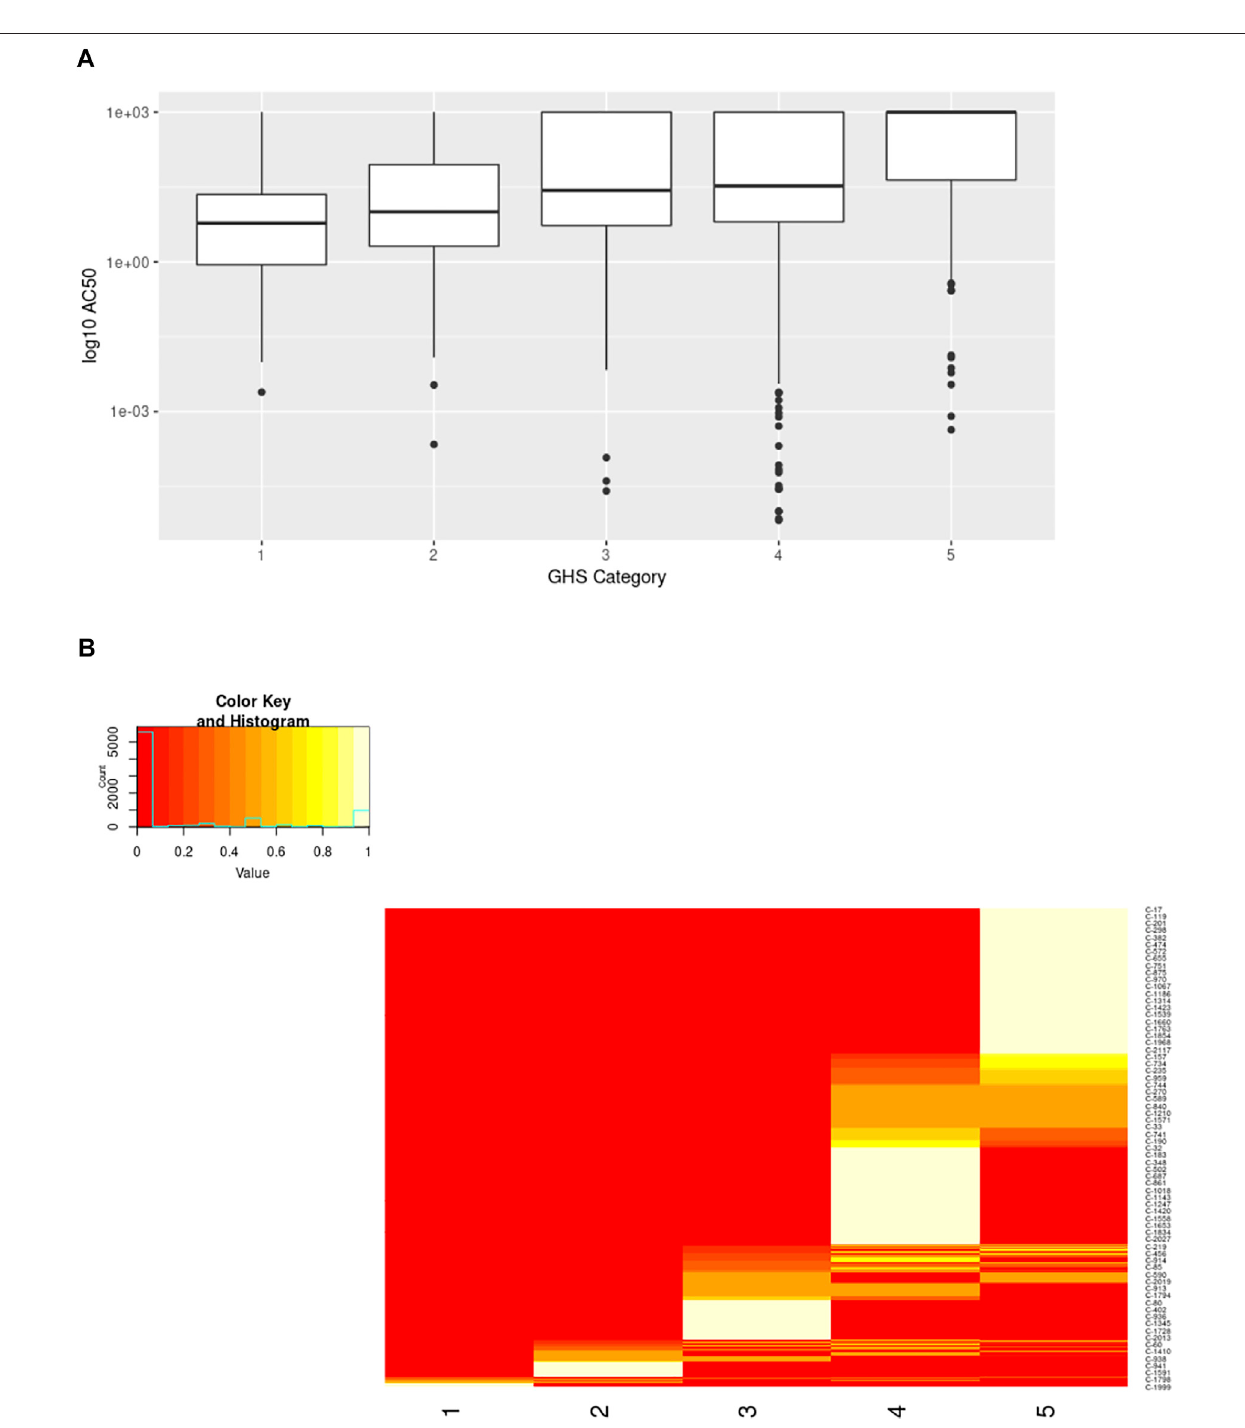
FIGURE 11 | Comparison of ToxCast AC50 values and structural clusters with GHS Categories. (A) Boxplots show the median along with the fi rst and third quartiles, and outliers are shown via dots and whiskers. Median AC50 values (micromolar) for each GHS category are as follows: 1 = 5.97, 2 = 10, 3 = 27, 4 = 33, 5 = 1000. (B) Heatmap shows the percentage of the chemicals within a cluster having the speci fi ed GHS category. The majority of clusters span 1-2 neighboring GHS categories.